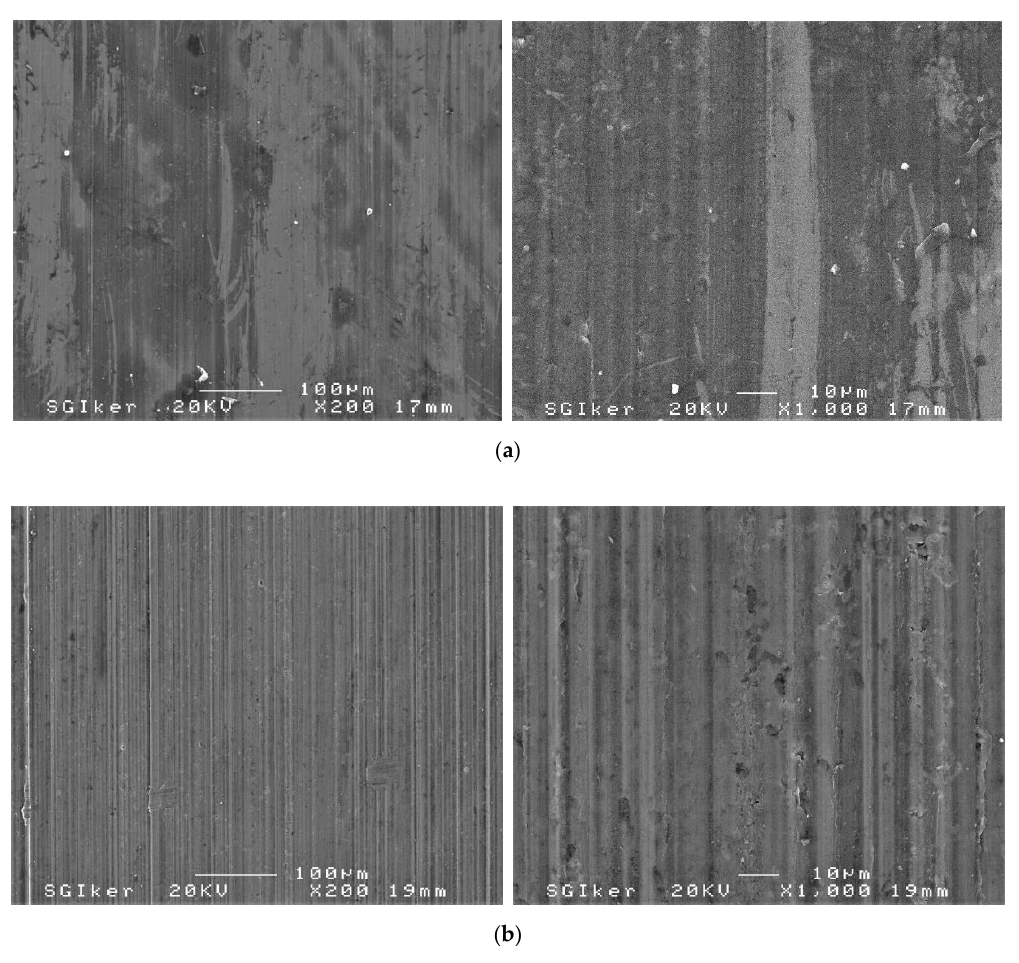
Figure 8. SEM micrographs that show wear in the AA5083-N0-T200 cam after 200 × 10 3 rev: ( a ) upper zone; ( b ) lower